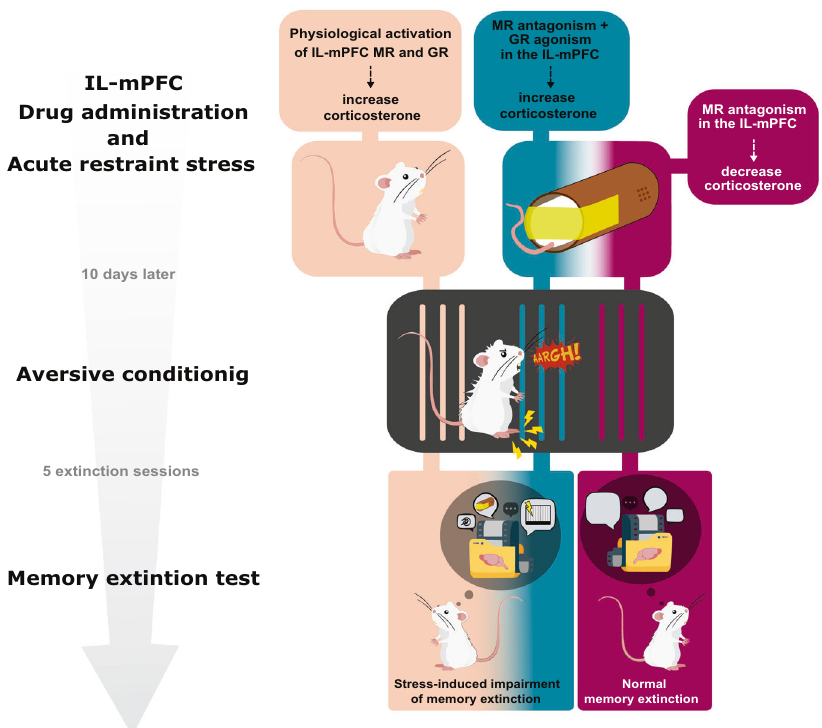
Fig. 5 The relevance of infralimbic MR and GR activation during acute restraint stress in the stress-induced corticosterone release and late memory processes. The infralimbic MR blockage by spironolactone during restraint stress, but not the concomitant modulation of the MR by CORT118335, a mixed MR/GR selective modulator (MR antagonist + GR agonist), reduced the stress-induced corticosterone release and rescued the impaired memory extinction in